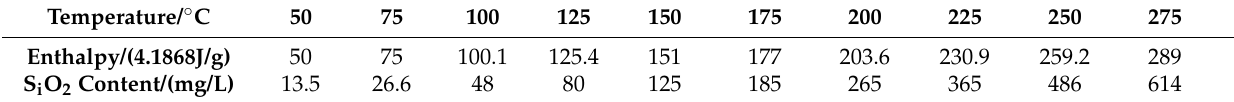
Table 3. The relationship between temperature, enthalpy, and SiO 2 content of hot water.